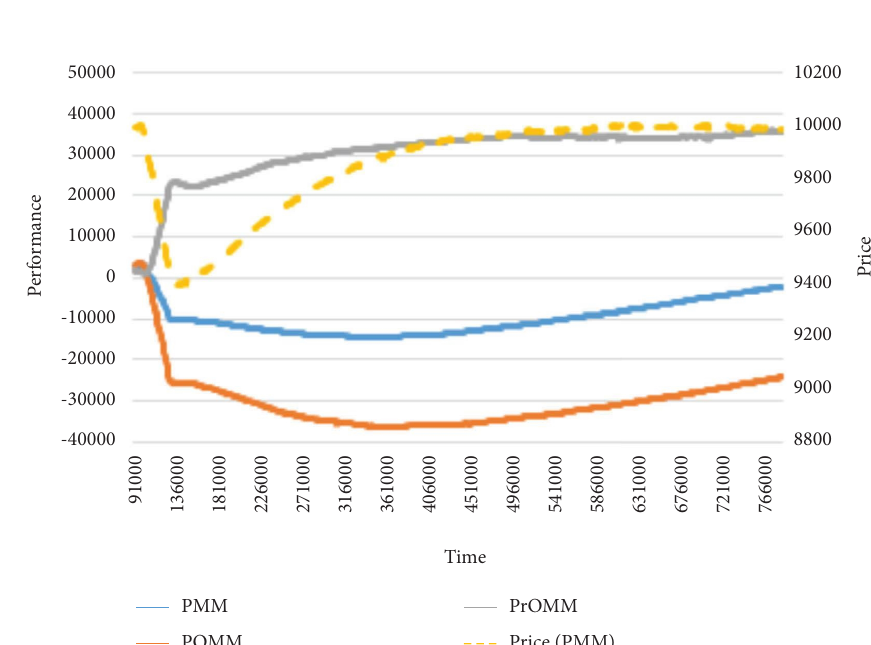
Figure 4: HFT agents’ performances in the unstable